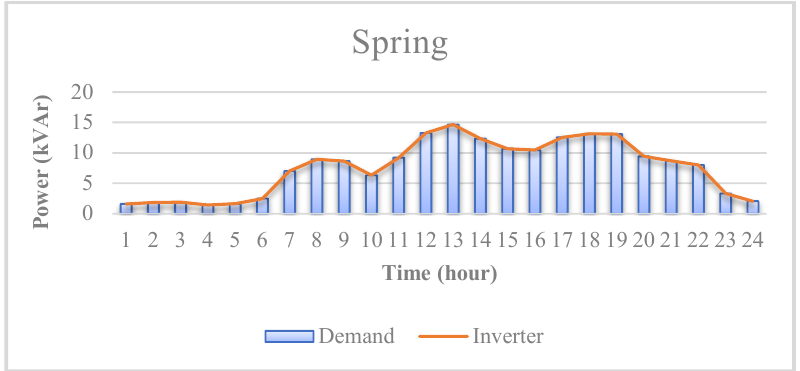
Figure 17. The reactive power support by smart inverters in spring.